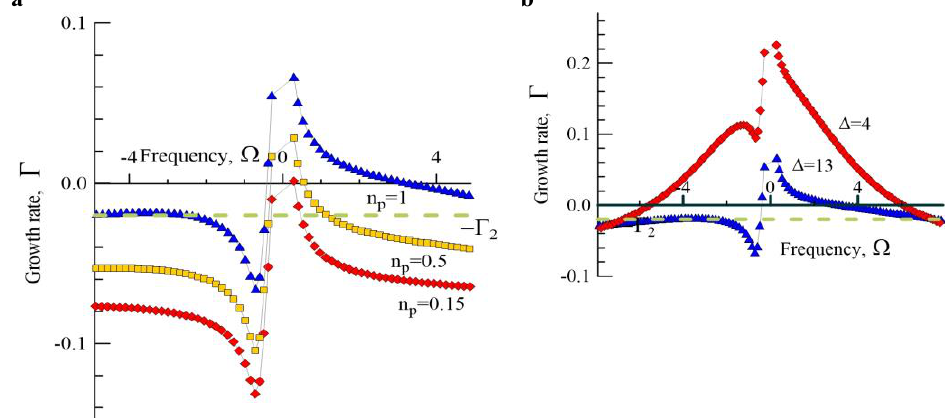
Fig. 5. Frequency dependences of the growth rates of hot modes of the combined FP-DFB cavity with length 20 L  , reflection factor 0.2 R  and DFB parameter 5 b  . (a) Influence of the population n  ) of the active medium with the inhomogeneous broadening of a inversion level ( 0.15;0.5;1 p spectral line 13   . (b) Influence of the inhomogeneous broadening of a spectral line ( 4;13   ) n  . In all cases, there is just the same weak relaxation rate under complete population inversion, 1 p of the polarization of active centers, 0.02   2